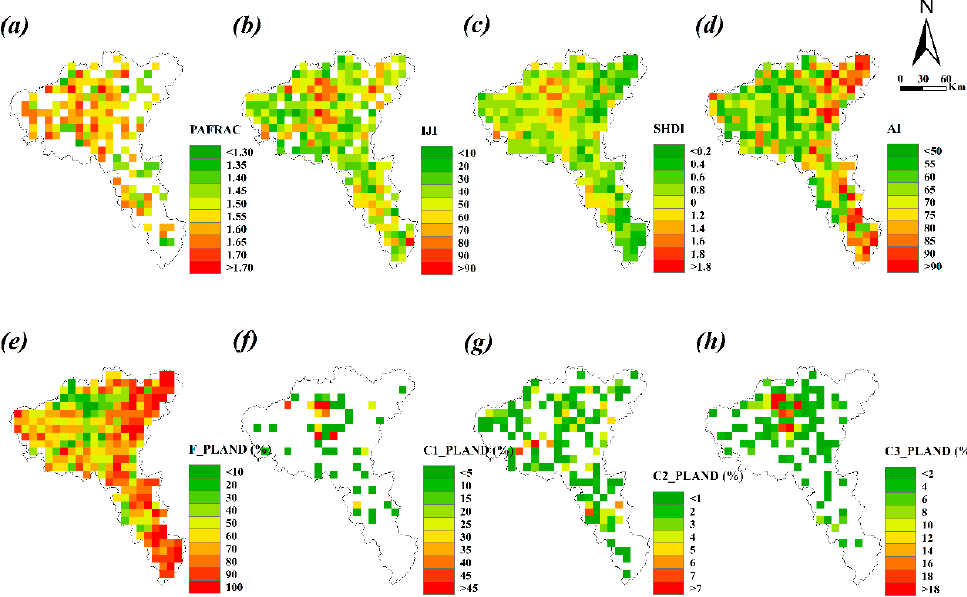
Figure 6. Landscape patterns of ( a ) PAFRAC; ( b ) IJI; ( c ) SHDI; ( d ) AI; ( e ) F_PLAND; ( f ) C1_PLAND; ( g ) C2_PLAND; and ( h ) C3_PLAND in the Chang-Zhu-Tan urban agglomeration.